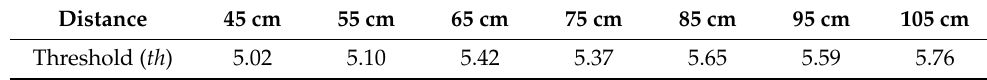
Table 2. Threshold th at different screen-shooting distances.